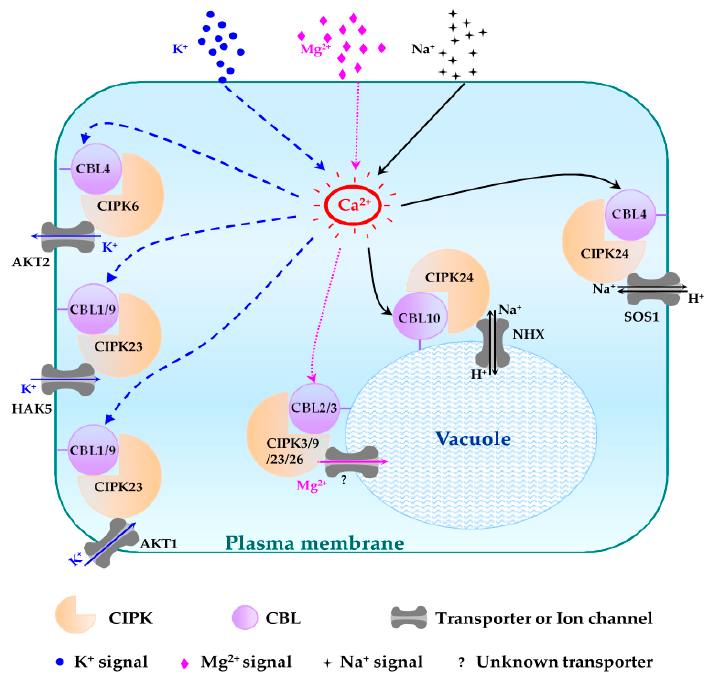
Figure 5. Schematic representation of different CBL ‐ CIPK complexes and their functions in regulating sodium (Na + ), potassium (K + ) and magnesium (Mg 2+ ) homeostasis. The regulatory pathways of K + , Mg 2+ and Na + are indicated in blue, pink and black lines, respectively. Question mark (?) indicates an unknown tonoplast ‐ localized transporter.